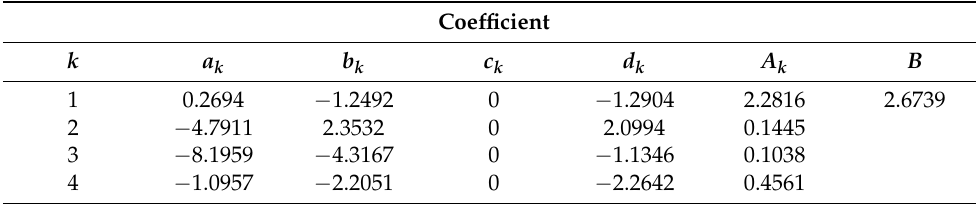
Table 7. Coefficient of Equation (8) for ANN5